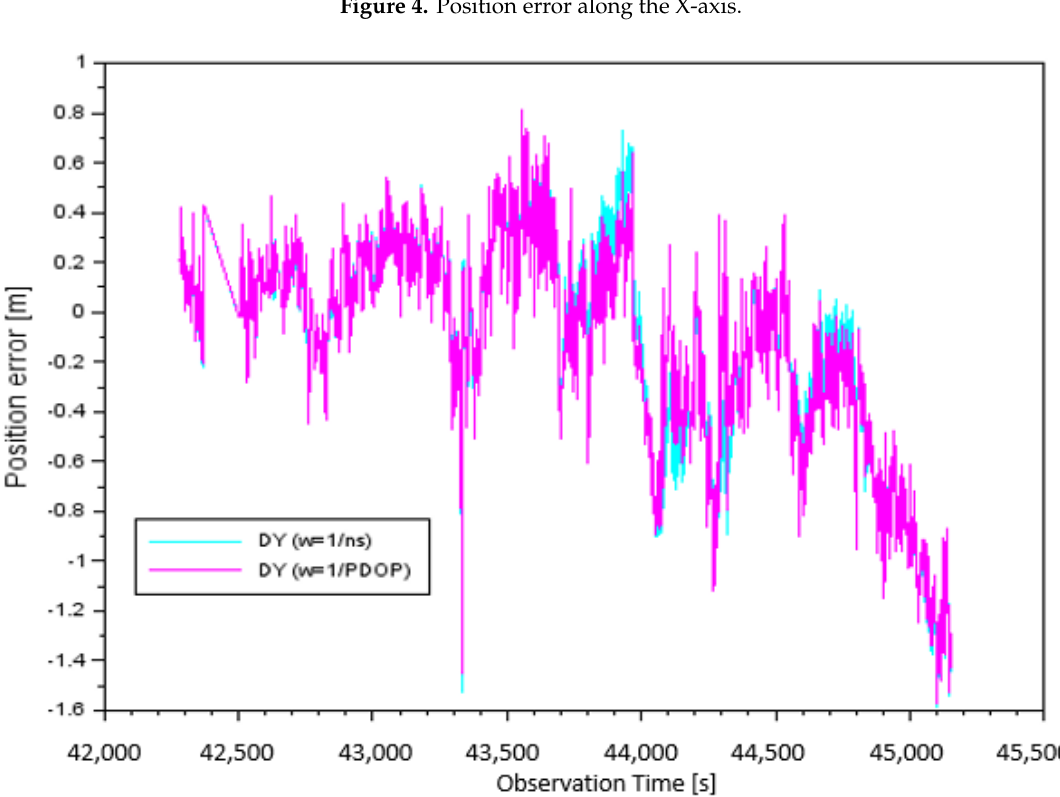
Figure 5. Position error along the Y-axis.